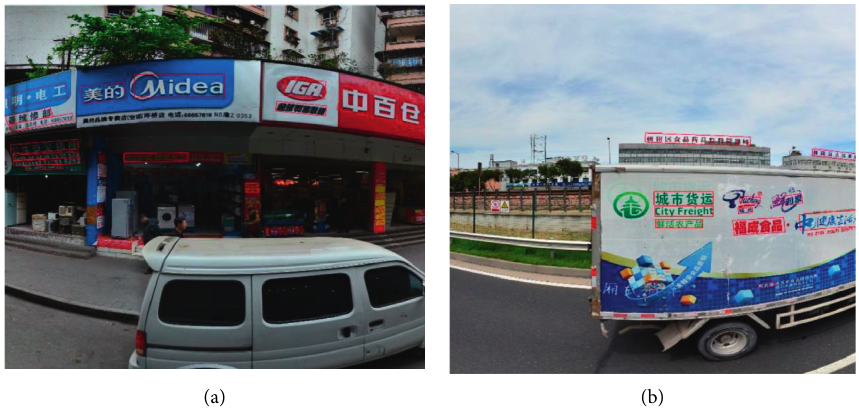
Figure 4: Recognition results of the AEMF algorithm from the MSRA-TD500 dataset.